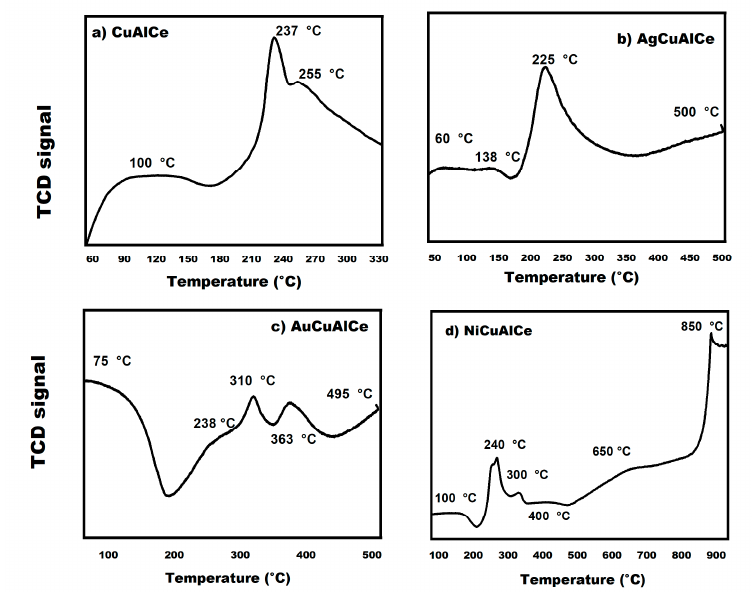
Figure 15. H 2 -TPR of ( a ) CuAlCe monometallic catalyst and ( b ) AgCuAlCe, ( c ) AuCuAlCe and ( d ) NiCuAlCe bimetallic-supported catalysts.